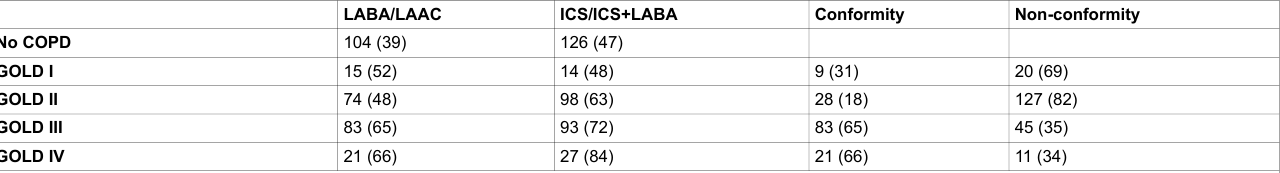
Table 5 Assessment of conformity to GOLD recommended use of long-acting bronchodilators and